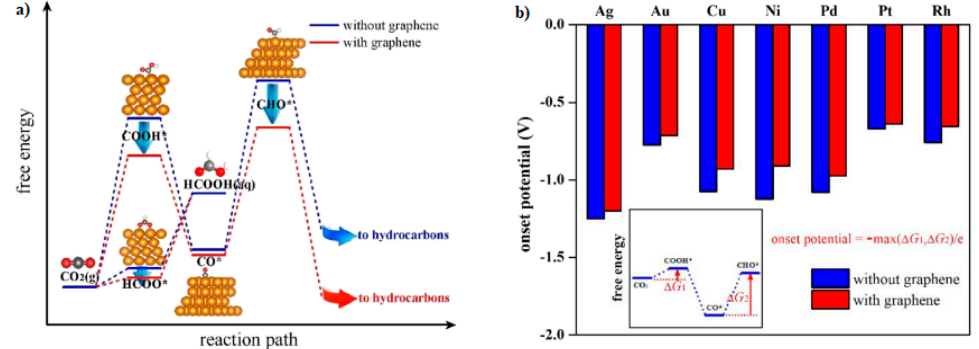
Figure 7. ( a ) A schematic free energy diagram. ( b ) Onset potentials for the electrochemical reduction reaction of carbon dioxide (ECO 2 RR) on metal surfaces with and without a graphene overlayer. Reproduced with permission [18].